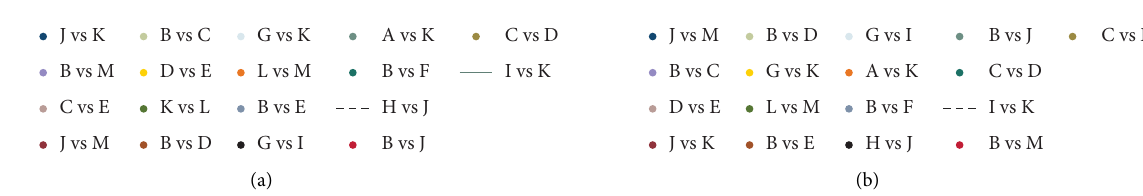
Figure 5: Funnel plot of this network meta-analysis. (a) Funnel plot of the daytime micturition frequency. (b) Funnel plot of the nocturia frequency.